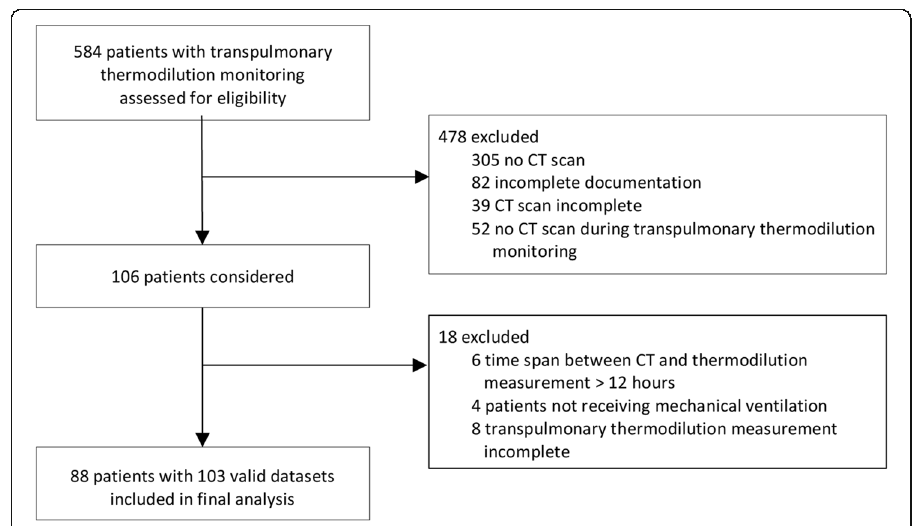
Fig. 1 Flow diagram of patient identification. CT computed